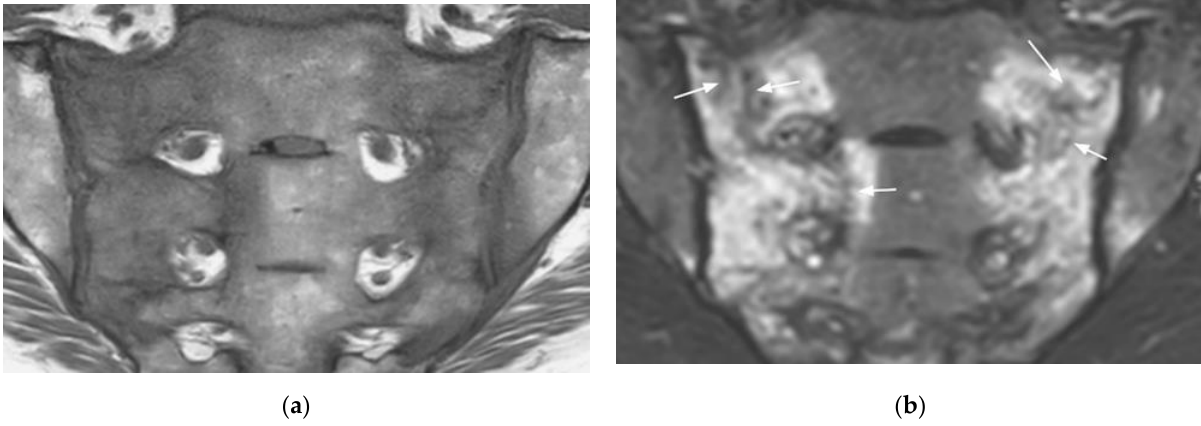
Figure 9. Sacral bone insufficiency fractures (coronal oblique T1- ( a ) and fat suppressed T2- ( b ) weighted images). Extensive BME on the sacral side of each SIJ containing thin irregular hypointense lines (fractures) (arrows).